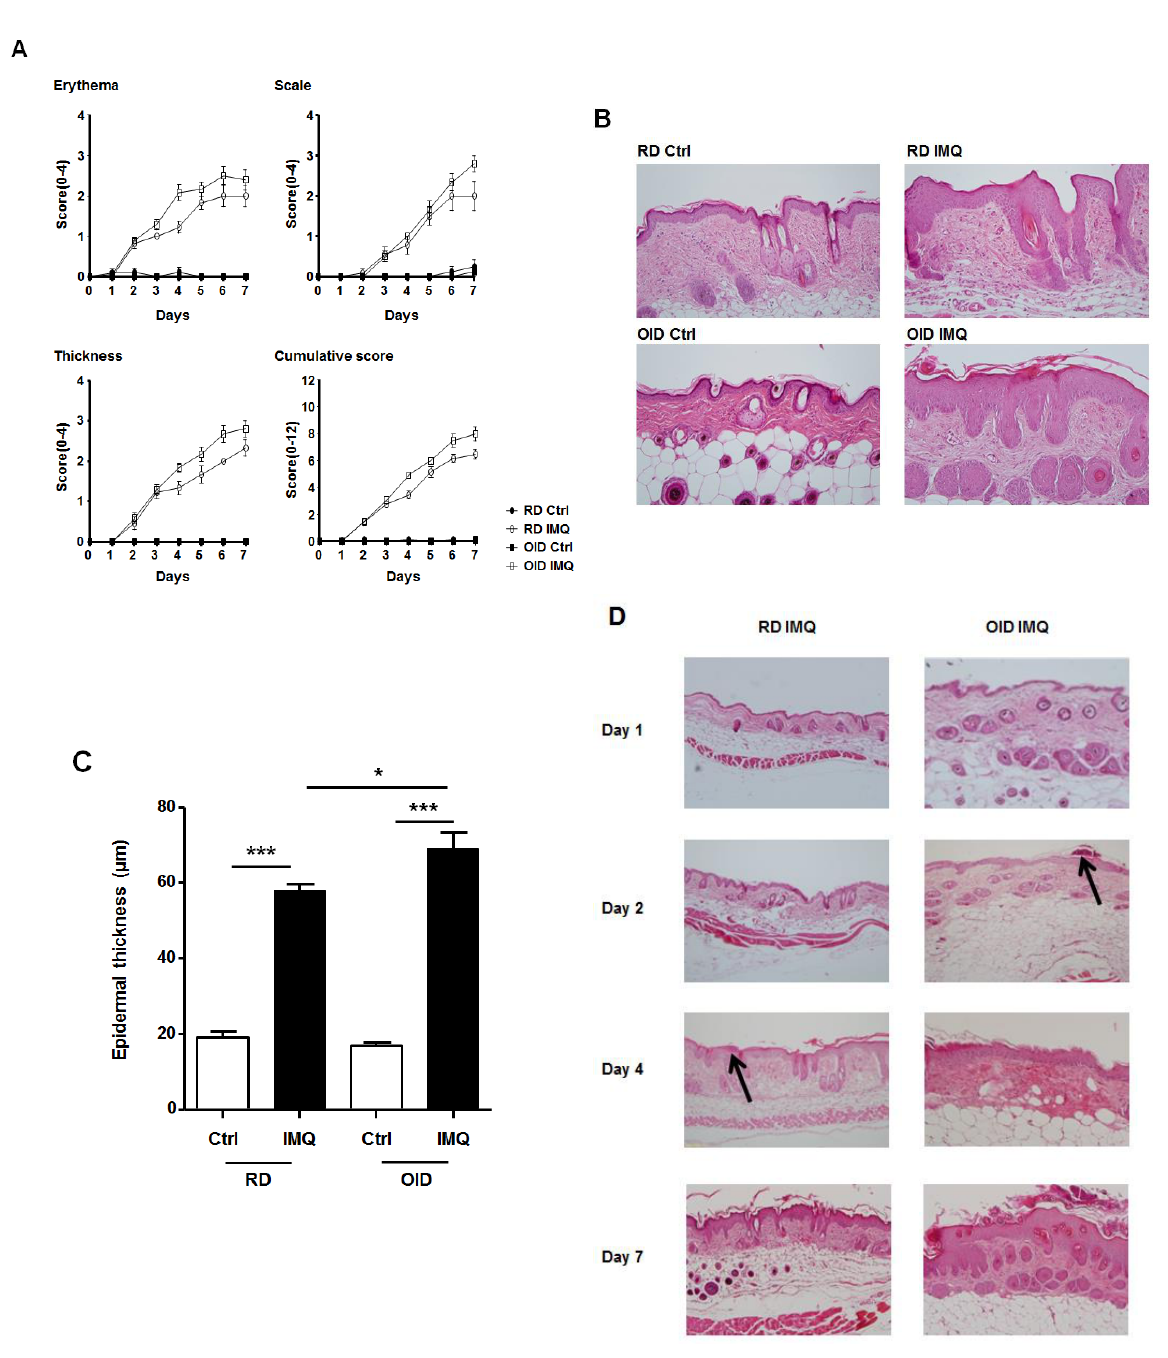
Figure 1. Exacerbated psoriasiform dermatitis and highly severe skin inflammation in imiquimod(IMQ)-treated mice reared on an obesity-inducing diet (OID) or regular diet (RD) ( n = 4–6/group/each time point). Control (Ctrl) indicates the mice not treated with imiquimod. Subfigure ( A ) shows the scores of psoriasis symptom parameters within time while ( B ) depicts the epidermal thickness of RD and OID groups after seven days of imiquimod treatment. Skin tissue from the backs of mice was stained with hematoxylin and eosin, imaged at × 200 magni- fication. Subfigure ( C ) indicates the epidermal thickness, measured from the dermo-epidermal junction to the granular layer. Data are represented as means ± SEM. * p < 0.05, *** p < 0.001. Subfigure ( D ) depicts the histological changes in skin tissue samples from the backs of mice 1, 2, 4, and 7 days after imiquimod administration. Arrows in the third panel on the left and the second panel on the right indicate an intra-corneal microabscess, a characteristic feature of psoriasis. Imaged at × 100